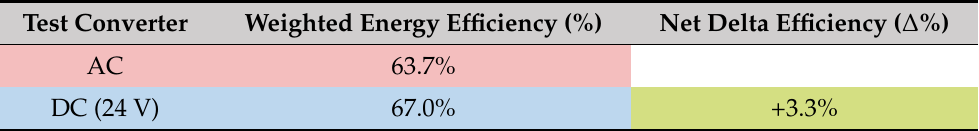
Table 9. Deltar Efficiency (DC-AC) for simulation with converters rated at 185